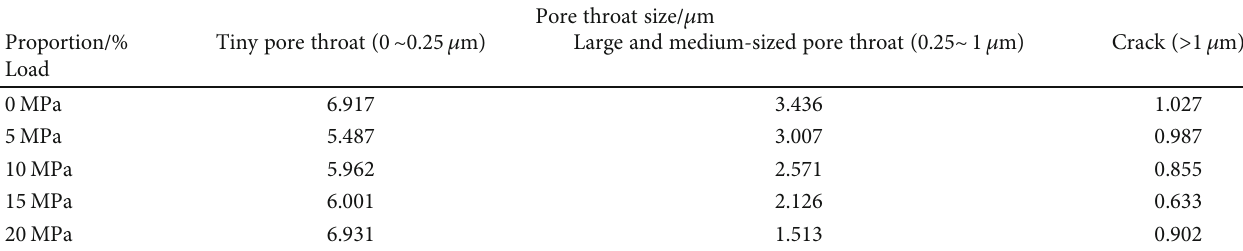
Table 3: Ratio of pore throat of di ff erent types of sandstone under di ff erent